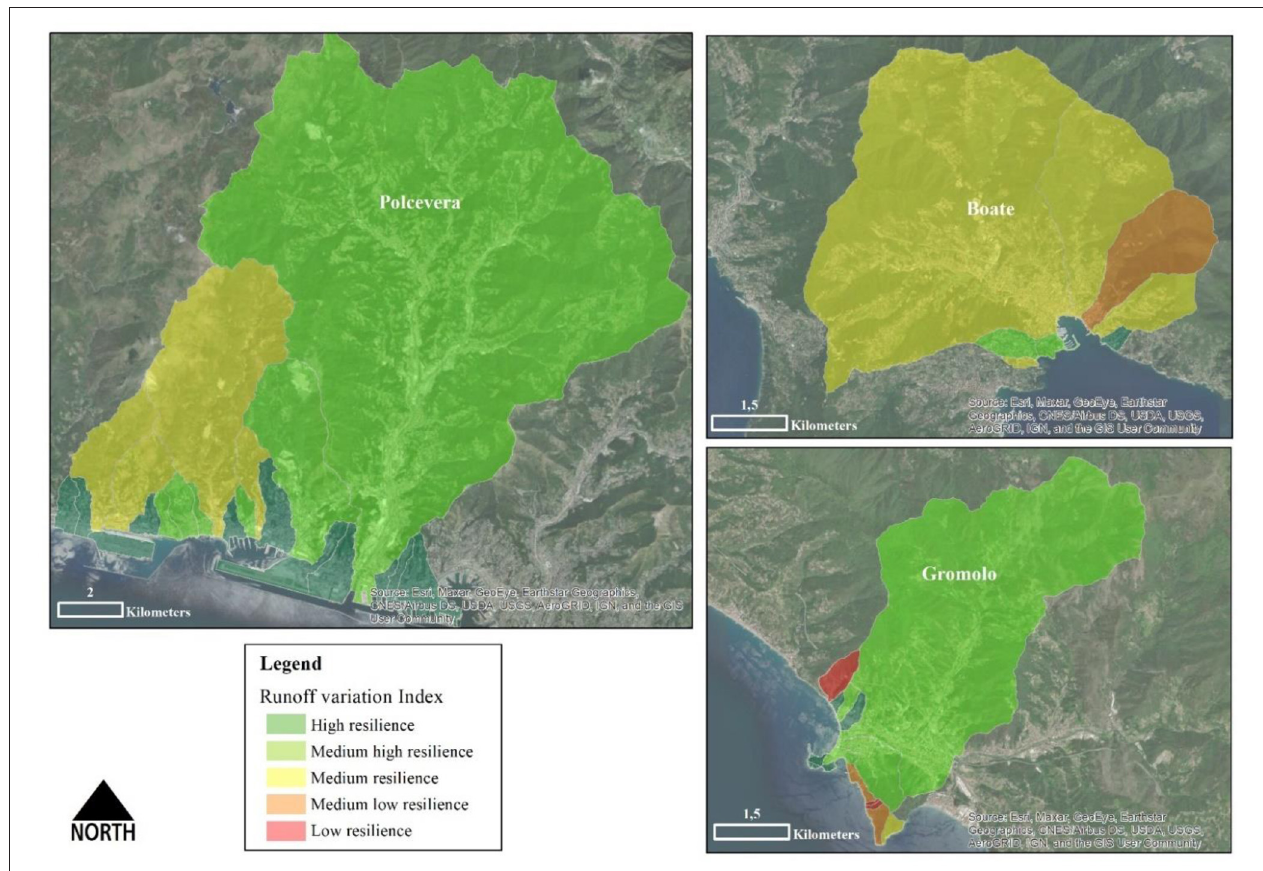
FIGURE 6 | Variation of runoff retention index from 50 to 70mm of rainfall (source: